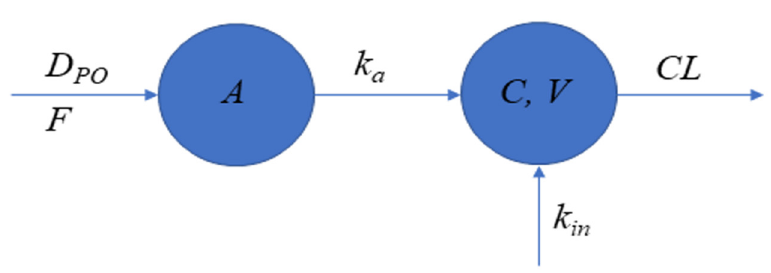
Figure 4. Graphic representation of PK model for myo-inositol. The serum concentration of myo- inositol was described by a one-compartment disposition model with first-order absorption and zero-order input rates: